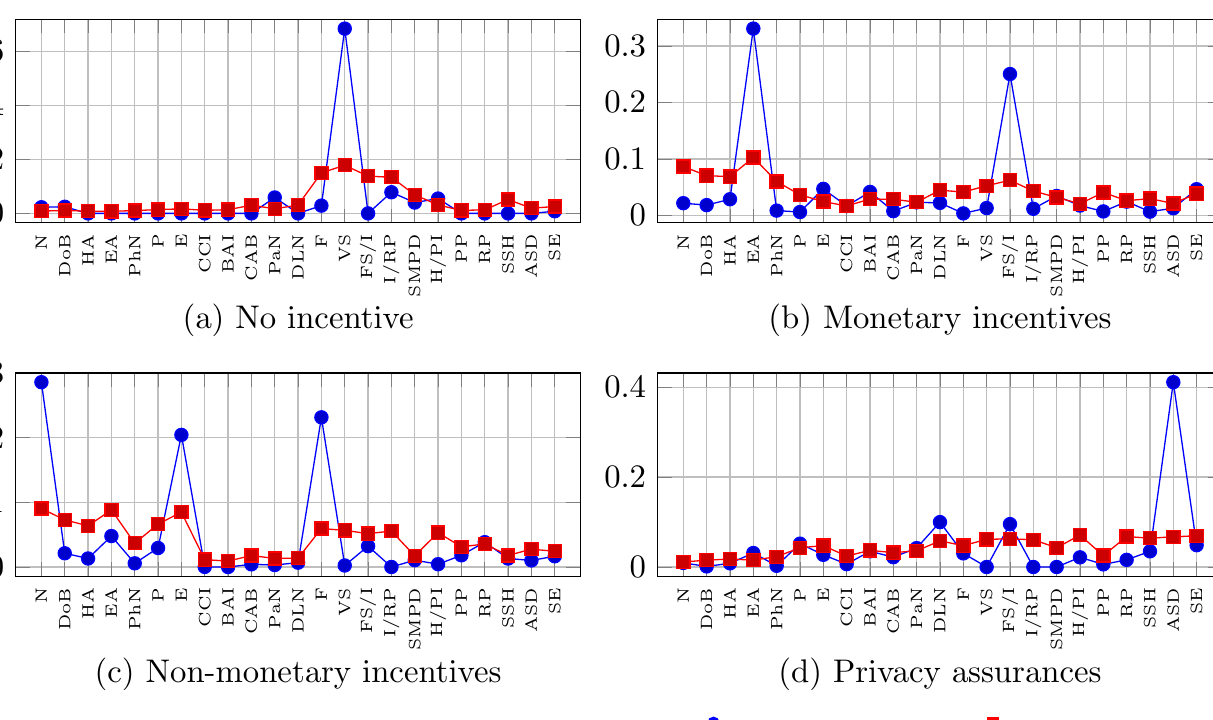
Figure 3. Feature significance levels of decision trees ( ) and random forests (